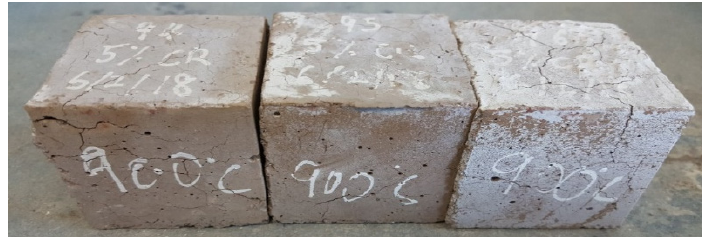
Figure 6. CR ‐ ECC with 5% CR at 900 °C.